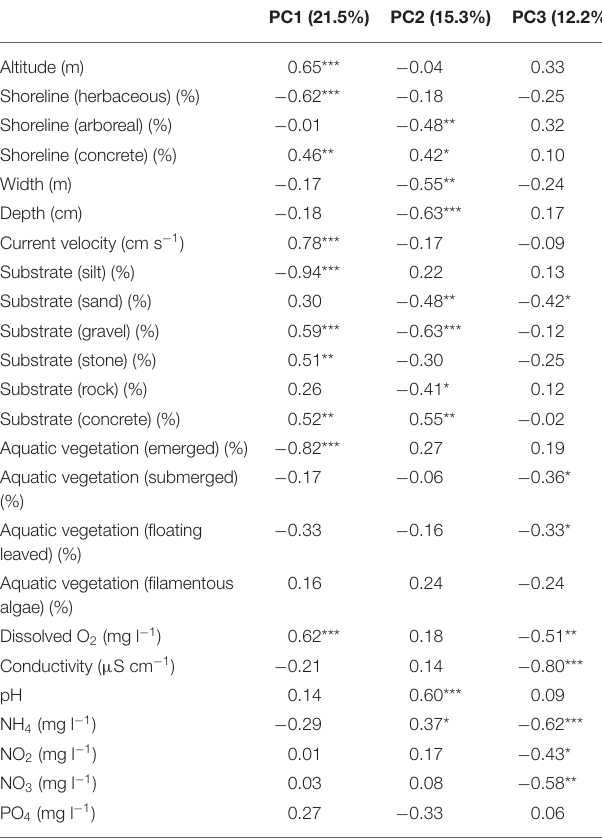
TABLE 2 | Results of the PCA conducted on the local habitat variables of the urban sites with the Spearman rank correlation values between the local habitat variables and PCA component scores of the sites.